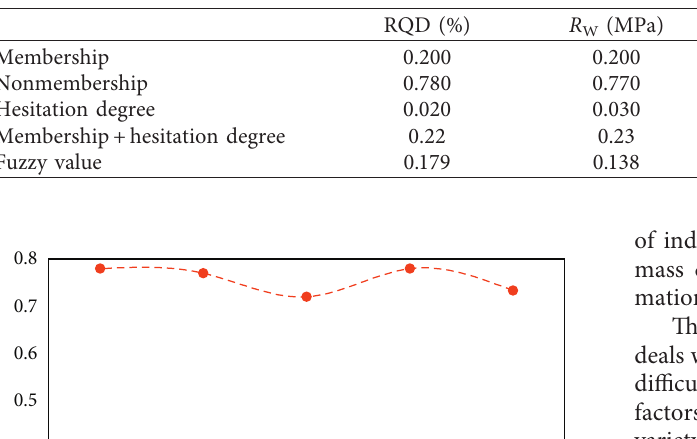
Table 7: Analysis of fuzzy value and weight.